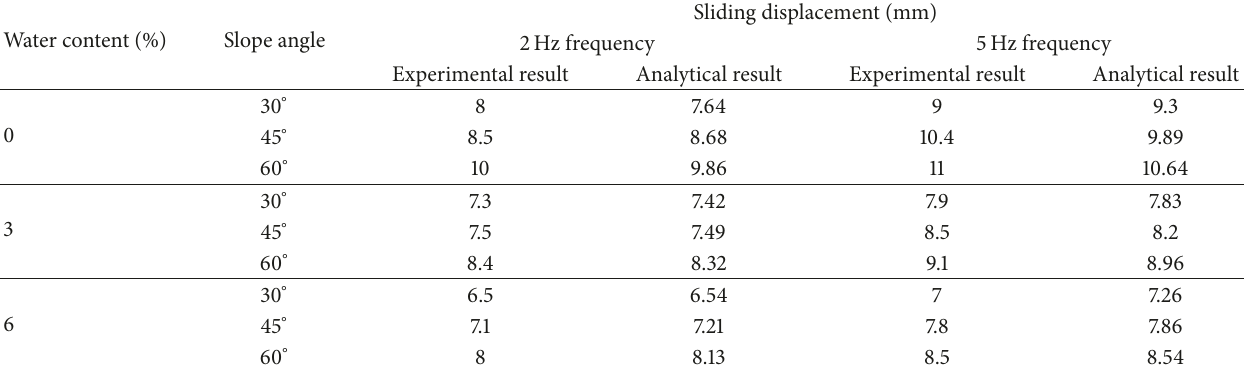
Table 7: Sliding displacement of slope made up of S + 30% BD from experimental result and pseudodynamic analysis .